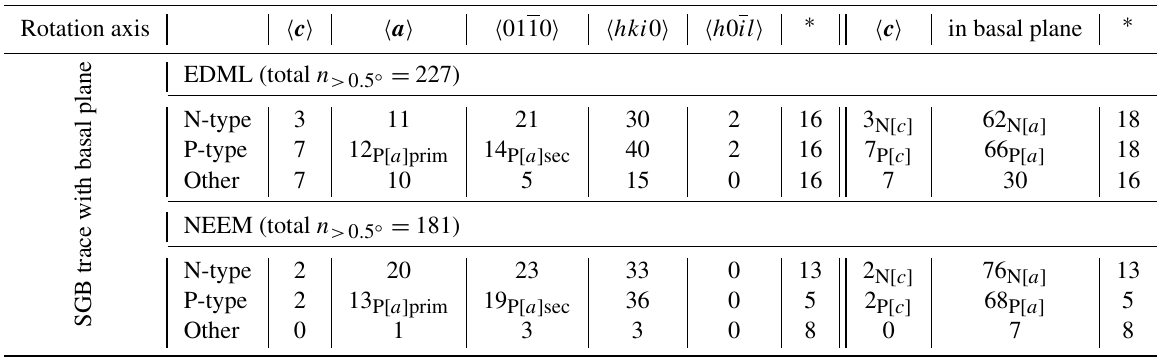
Table 2. Summary of the EBSD data statistics for EDML and NEEM samples. The columns show the SGB rotation axes, R , and the rows show the alignment of the SGB traces with respect to the basal plane shown in Fig. 5; n is the number of SGBs, and ∗ signifies dispersed rotation axes. The outermost three columns give simplified statistics of the same data set for comparison with X-ray Laue diffraction (Weikusat et al.,